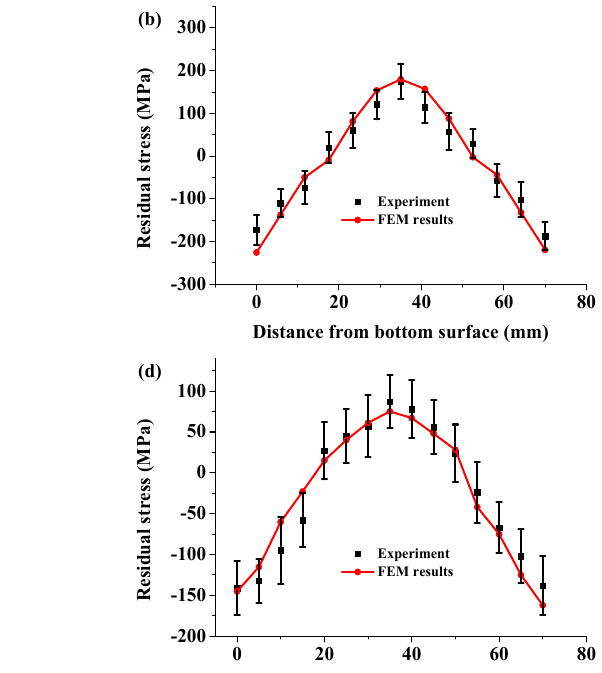
Figure 12. Comparisons between FEM and experimental results: ( a , b ) for quenched stress along path ab and cd, respectively; ( c , d ) for cold pressed stress along path ab and cd, respectively.